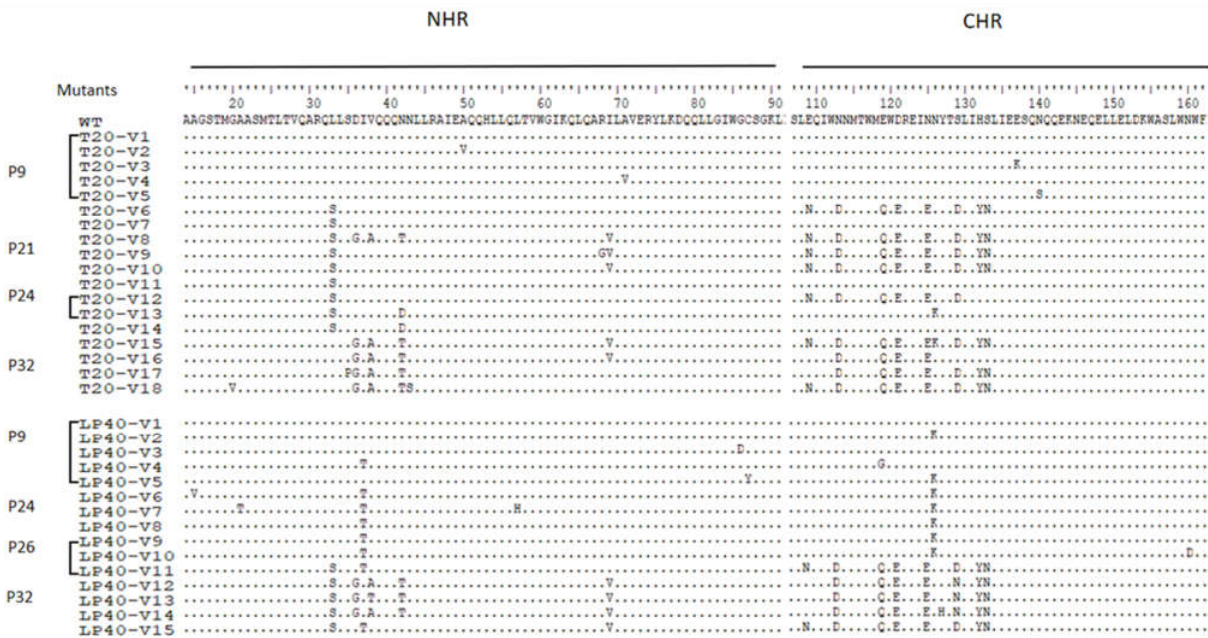
Figure 3. T20- and LP40-induced mutations in the gp41 region of HIV-1NL4-3. The amino acid sequences of wild-type (WT) and selected mutants are aligned. The positions of selected substitutions are in bold, and the numbering is according to that of HIV-1HXB2 gp41. WT,